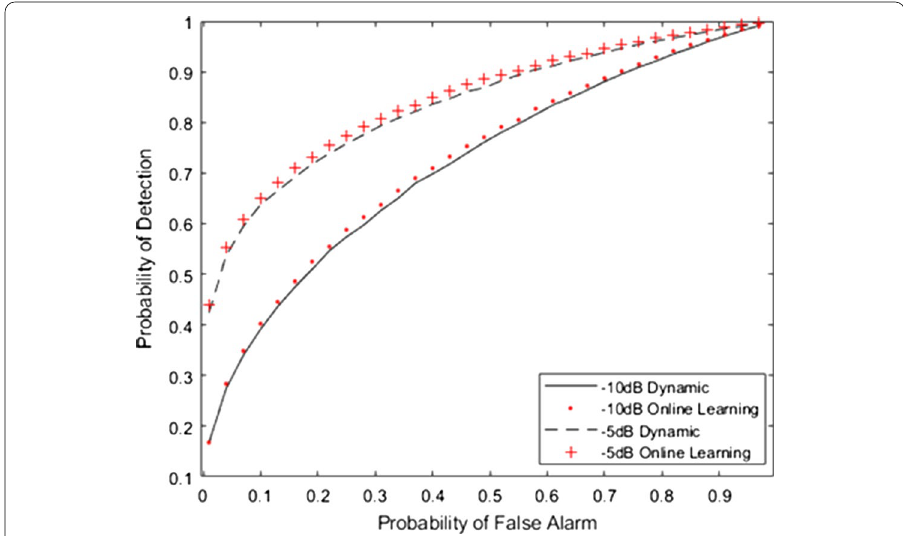
Fig. 4 ROC ( P d vs P fa ) of energy detector sensing under AWGN